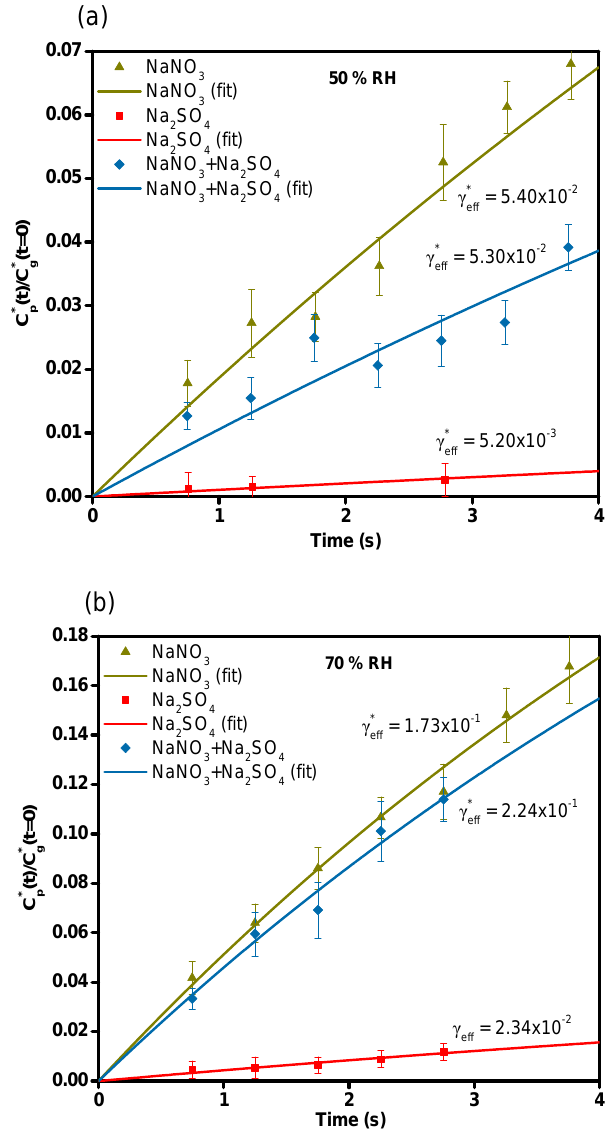
Figure 2. Normalized particle-phase labelled nitrate concentration vs. time for experiments performed at 50% RH (a) and 70% RH (b). The data points represent the measurement data, the error bars represent the standard deviation of the measurements, the curves are a least-squares fit of Eq. 1 to the measured data.